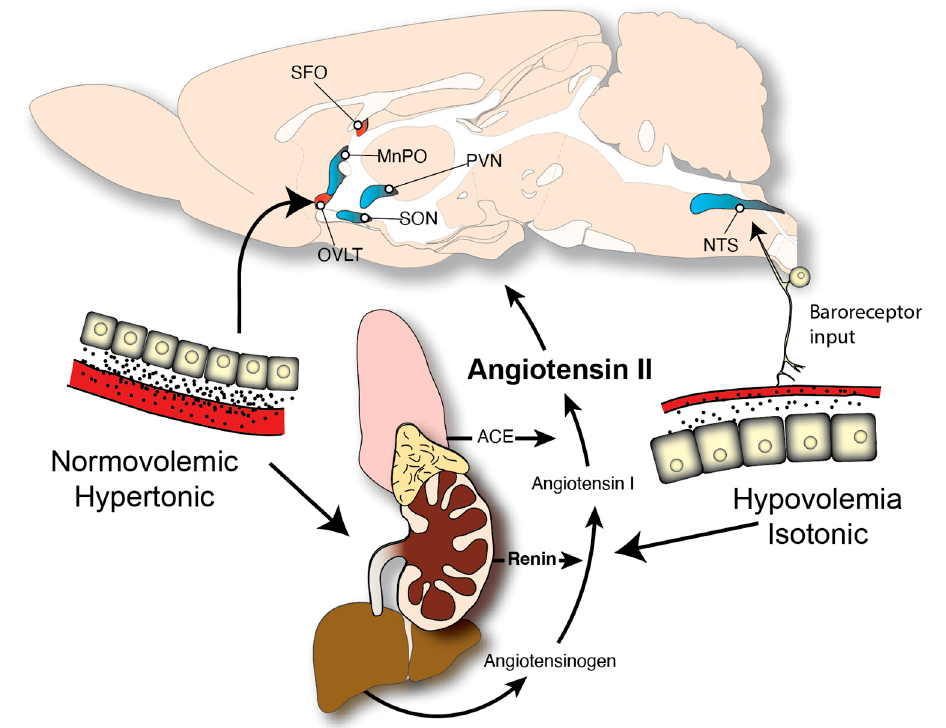
Figure 1. The renin-angiotensin system and its role in the double-depletion model of thirst and sodium intake. The renin-angiotensin system engaged by fluid loss. The active peptide of this system, angiotensin II, is generated by a biosynthetic pathway beginning with angiotensinogen, a relatively large liver protein that is abundant in circulation. Upon activation of the renin-angiotensin system, the kidney secretes renin, which cleaves angiotensinogen to form angiotensin I. Angiotensin I is further cleaved by angiotensin converting enzyme (ACE), which is expressed mainly in the lungs, to form angiotensin II, which acts on a variety of targets, including the brain. The stimuli that trigger thirst, and in some cases an accompanying sodium appetite, can be divided into intracellular and extracellular effects. In the case of intracellular dehydration, the extracellular volume remains constant in terms of volume (normovolemic), but with a greater concentration of solutes (hypertonic). In this case, the cells lose volume by osmosis, and this triggers activity of osmoreceptors in the brain, primarily in the OVLT, as well as activation of the renin-angiotensin system. In the case of extracellular dehydration, fluid and solutes are lost from the extracellular space. The concentration remains normal (isotonic), so there is no loss of water from the intracellular space, but the volume of the extracellular compartment is reduced (hypovolemia). The loss of volume and blood pressure